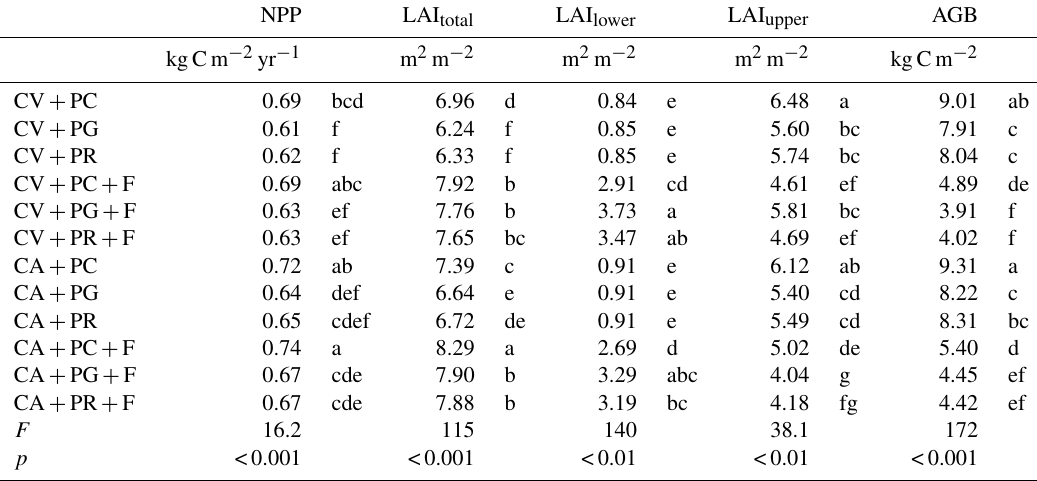
Table 6. Summary of average NPP, LAI and AGB for the Amazon–Cerrado transition zone over the transect domains, considering all factor combinations. One-way ANOVA results are also shown, including F statistics and p values. Values within each column followed by a different letter differ significantly ( p <0.05) according to the Tukey–Kramer test ( n = 310: 31 pixels × 10